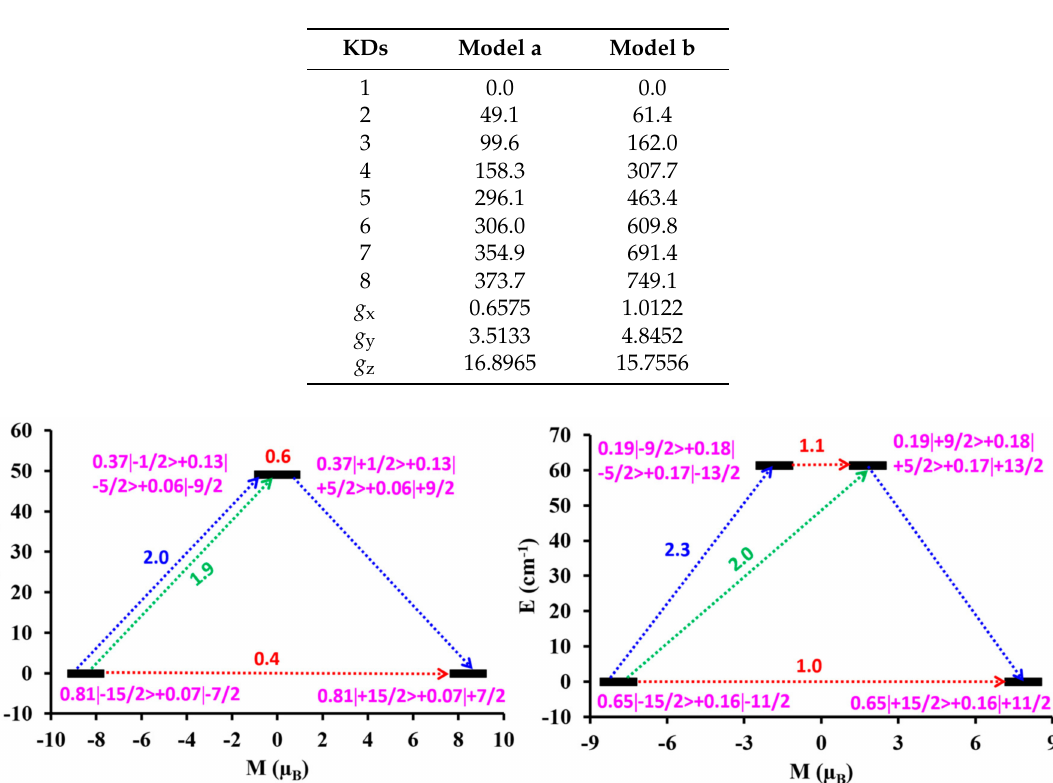
Table 2. Ab initio Computed Eight Low-lying Kramers Doublet energies (cm − 1 ) and g -tensors of ground Kramers Doublet in model complexes a and b .